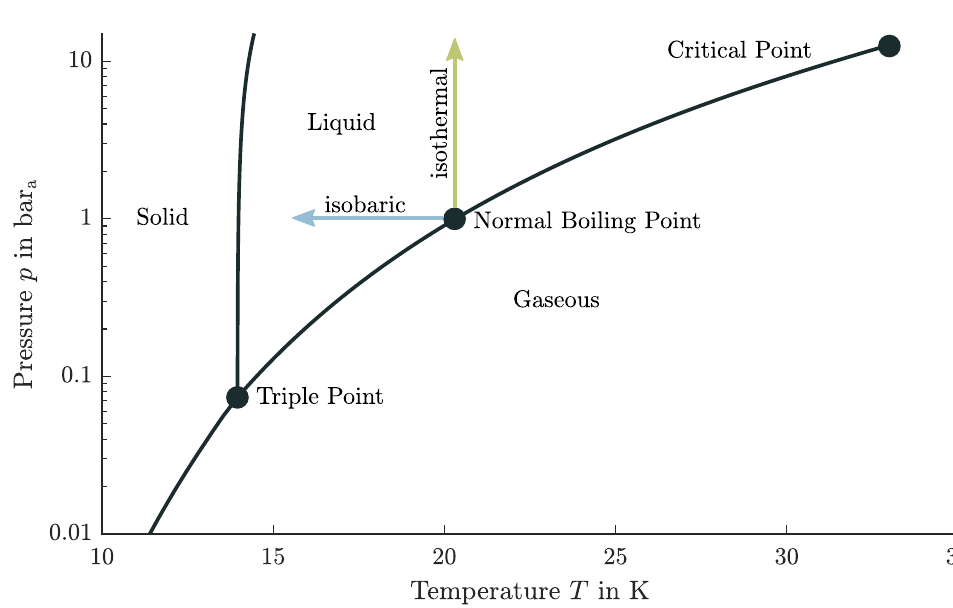
Figure 1. Phase diagram of parahydrogen [36]; isothermal and isobaric subcooling starting from Normal Boiling Point